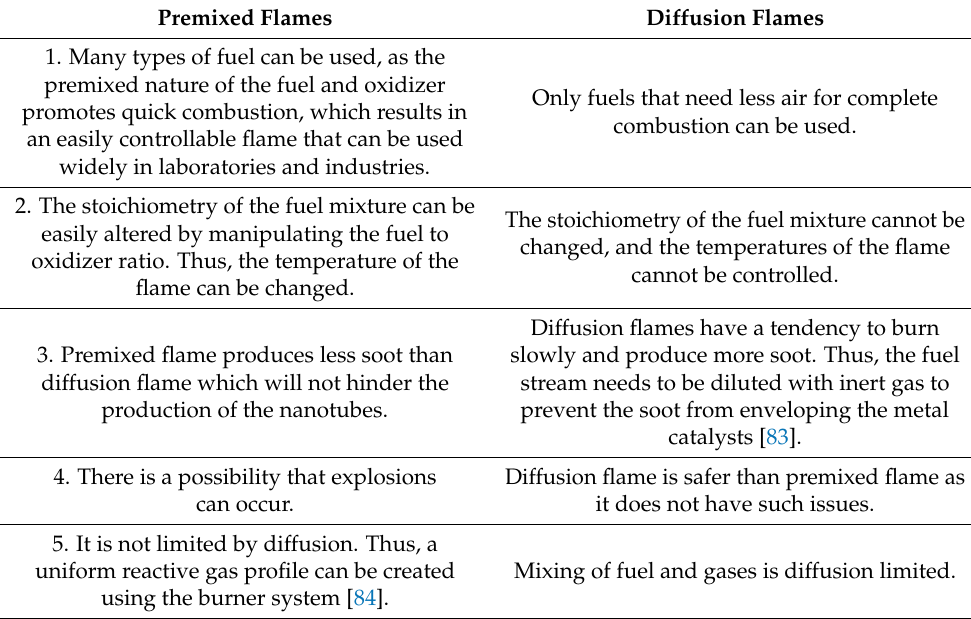
Table 3. Differences between premixed and diffusion